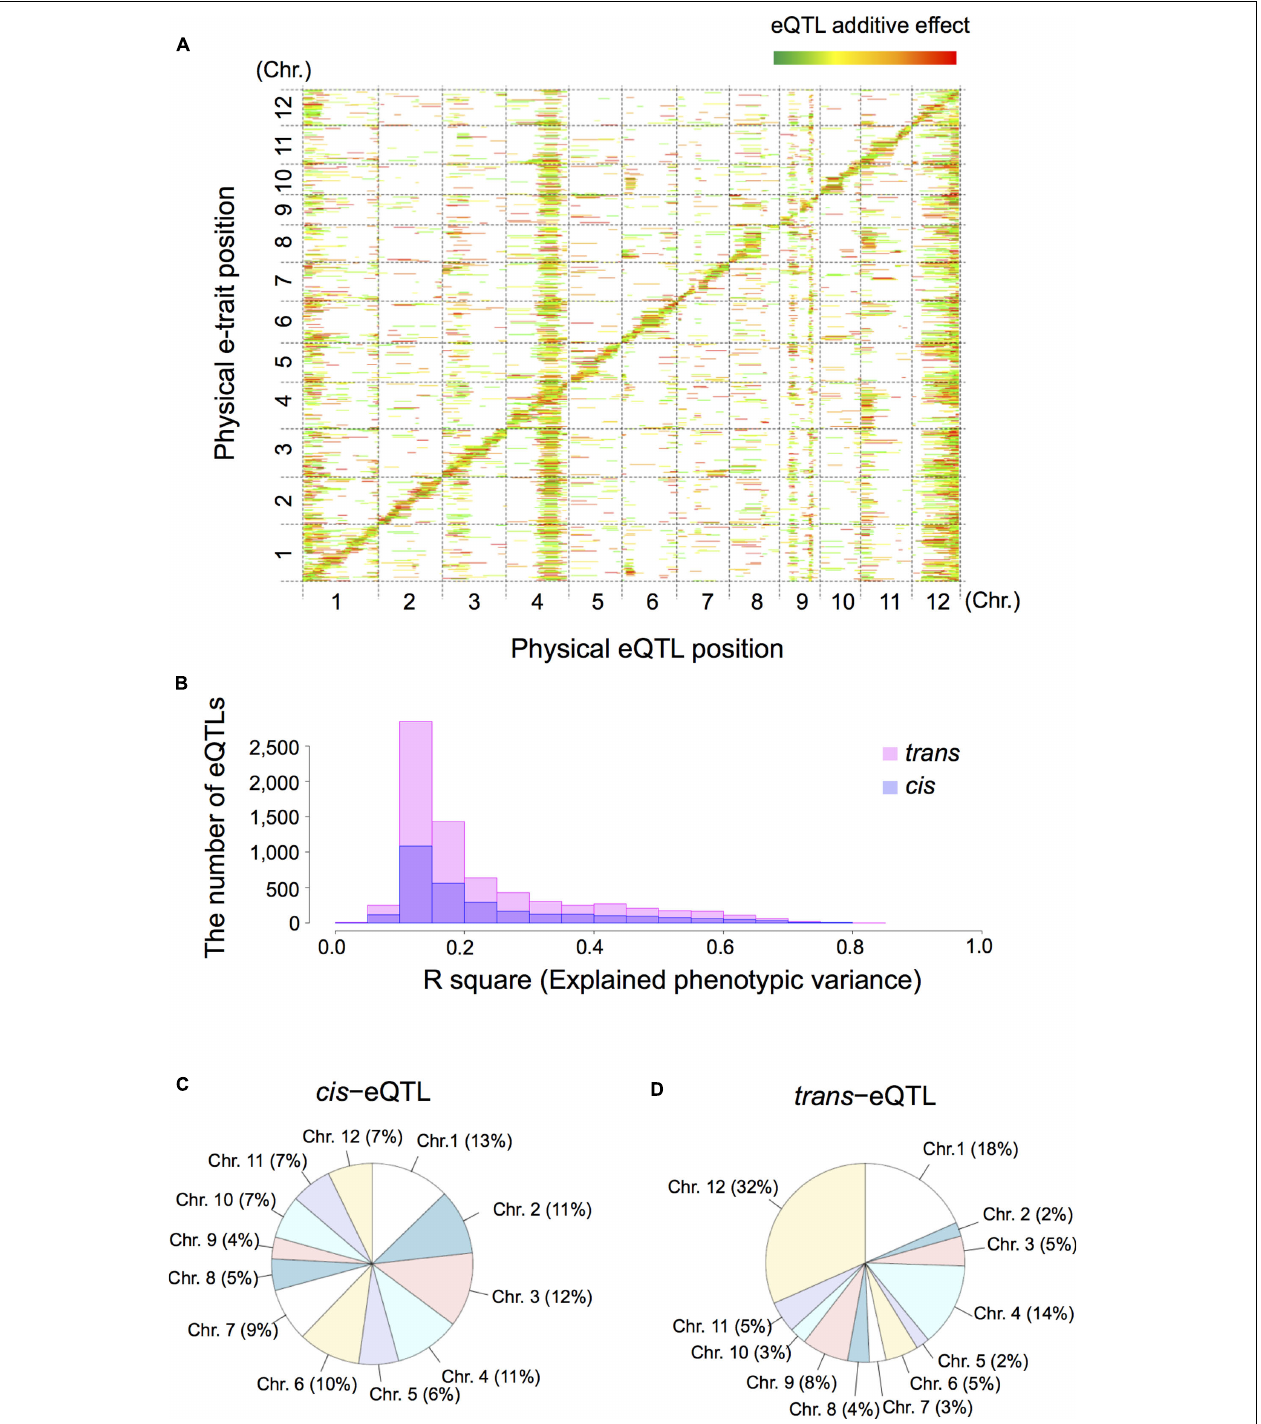
FIGURE 2 | Summary of expression quantitative trait loci (eQTLs) and their location in the rice genome. We analyzed shoot tissue of germinating RIL seeds obtained by crossing T65 and Bhadua rice. (A) The eQTL heatmap for T65/Bhadua populations was significant at a 5% false discovery rate (FDR). The x -axis represents the genetic position of the detected eQTLs and the y -axis the physical position of expressed genes (e-traits). The 12 rice chromosomes are separated by dashed lines. The pseudo-colors indicate the LOD scores (from green to red in order of the increasing LOD score). The bar length along the x -axis indicates the eQTL support interval. (B) Distribution of the R-square based on analysis of variance (ANOVA), the proportion of phenotypic variation explained by the segregation of an individual QTL or the significant QTL interactions for all eQTLs. (C) Pie chart of the proportion of cis -eQTLs distributed on 12 rice chromosomes. (D) Pie chart of the trans -eQTLs distributed on 12 rice